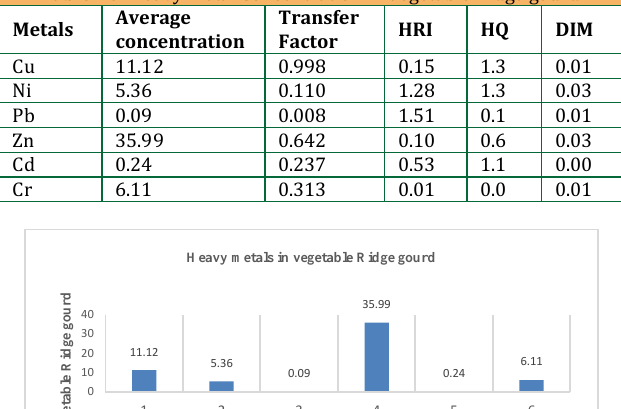
Table 20: Heavy metal Concentration in Vegetable Ridge gourd.